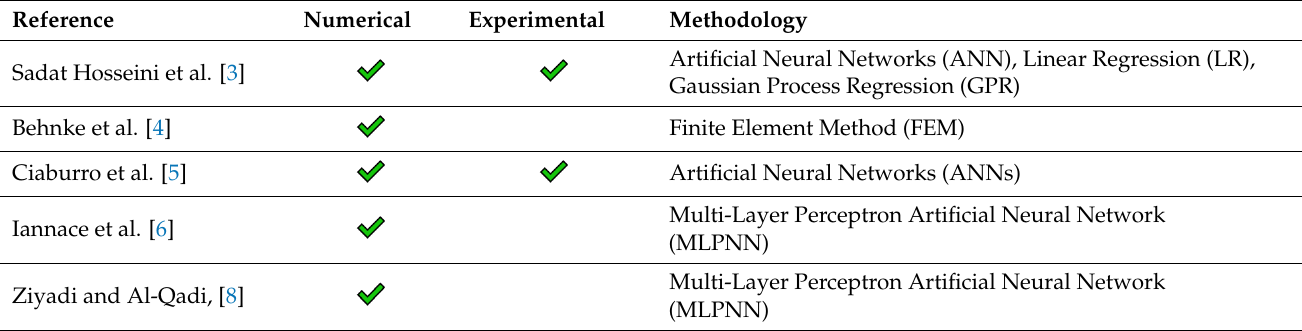
Table 2. Comparison of methods used in prediction of flexible pavement performance.